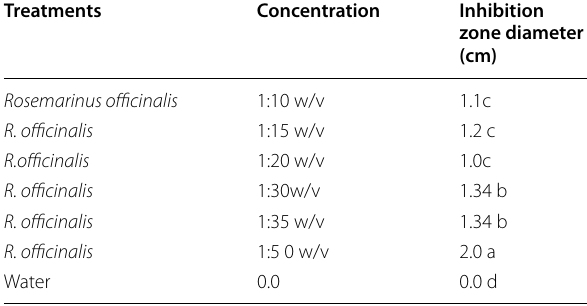
Values in the column followed by different letters indicate significant differences among treatments according to a least significant differences test ( P Table 2 Effect of Rosemarinus officinalis and Pseudomonas fluorescens on growth of Ralstonia solanacearum in vitro